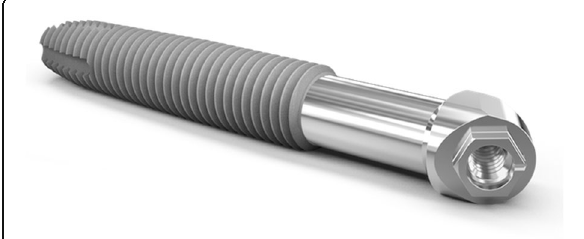
Fig. 1 Zygomatic oncology implant with cleansable polished surface for intra-oral component